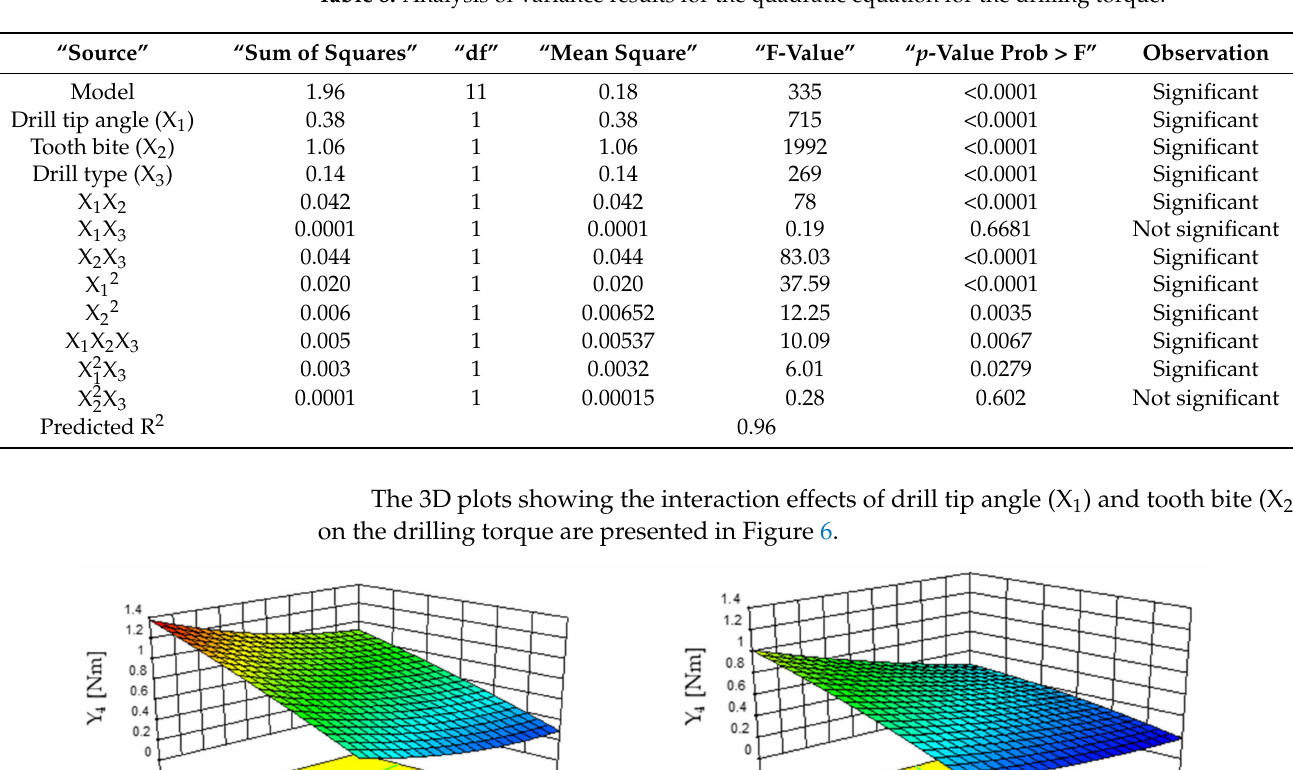
Table 8. Analysis of variance results for the quadratic equation for the drilling torque.